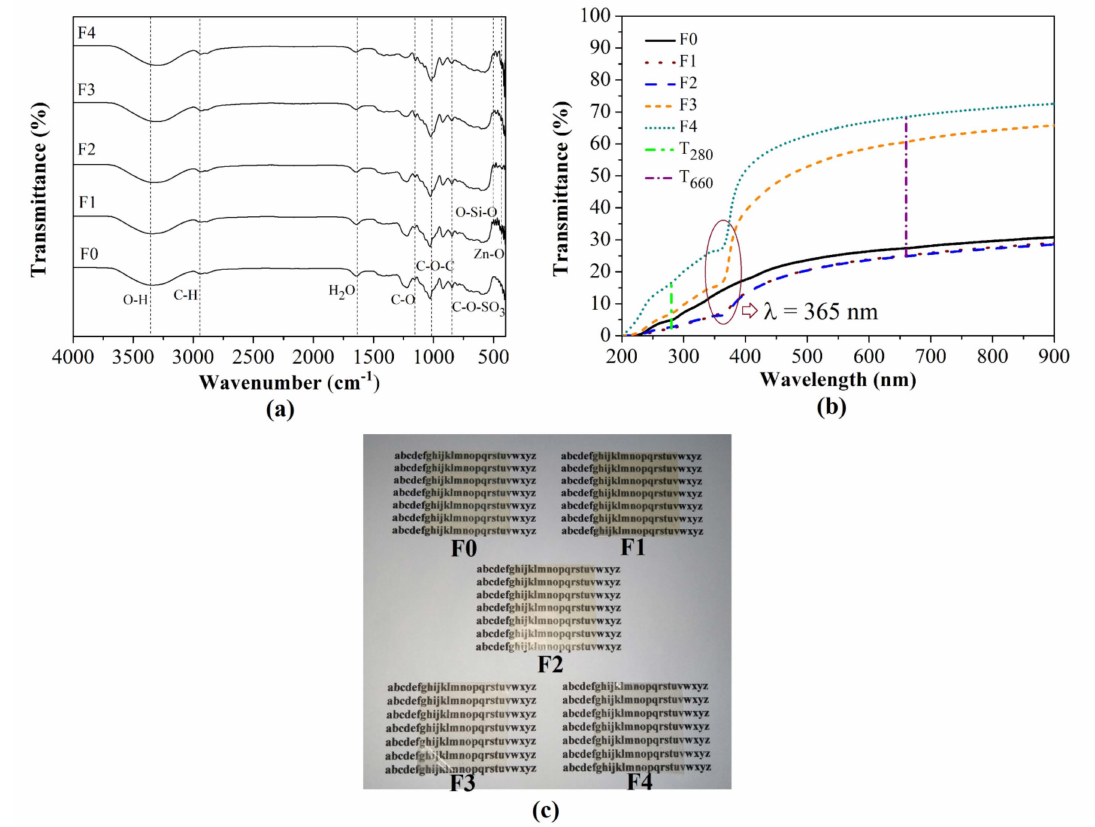
Figure 1. FTIR spectra ( a ), UV light transmittance ( b ), and appearance ( c ) of bionanocomposite and control films. F0: SRiC film (control film), F1: SRiC film with SiO 2 -ZnO nanoparticles, F2: SRiC/CS (1.5 wt%: 0.5 wt%) with SiO 2 -ZnO nanoparticles, F3: SRiC/CS (1.0 wt%: 1.0 wt%) with SiO 2 -ZnO nanoparticles, F4: SRiC/CS (0.5 wt%: 1.5 wt%) with SiO 2 -ZnO nanoparticles, T 280 : transmittance value at 280 nm, and T 660 : transmittance value at 660